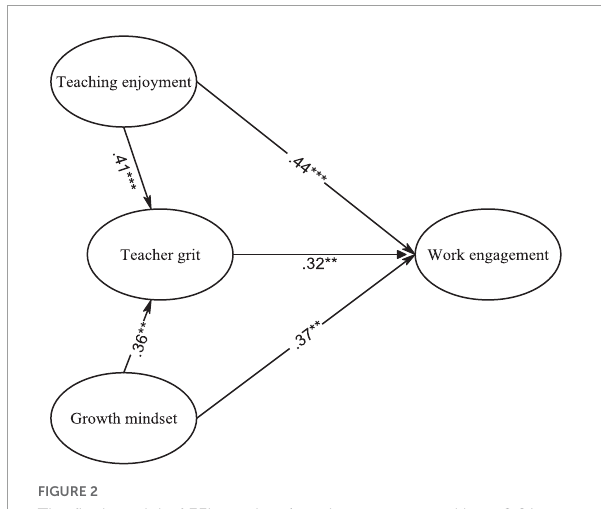
FIGURE2 The final model of EFL teachers’ work engagement. ** p < 0.01. *** p <